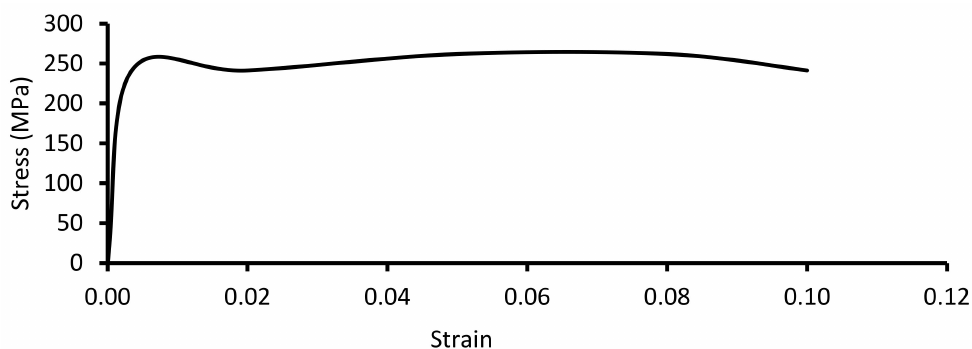
Figure 9. Average stress–strain curves for the longitudinal reinforcement bars.